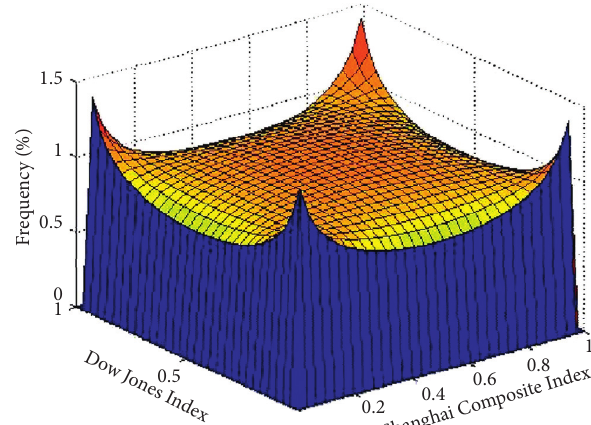
Figure 5: T-Copula distribution of SSE index and Dow Jones Index extreme volatility series based on B segment weekly data.